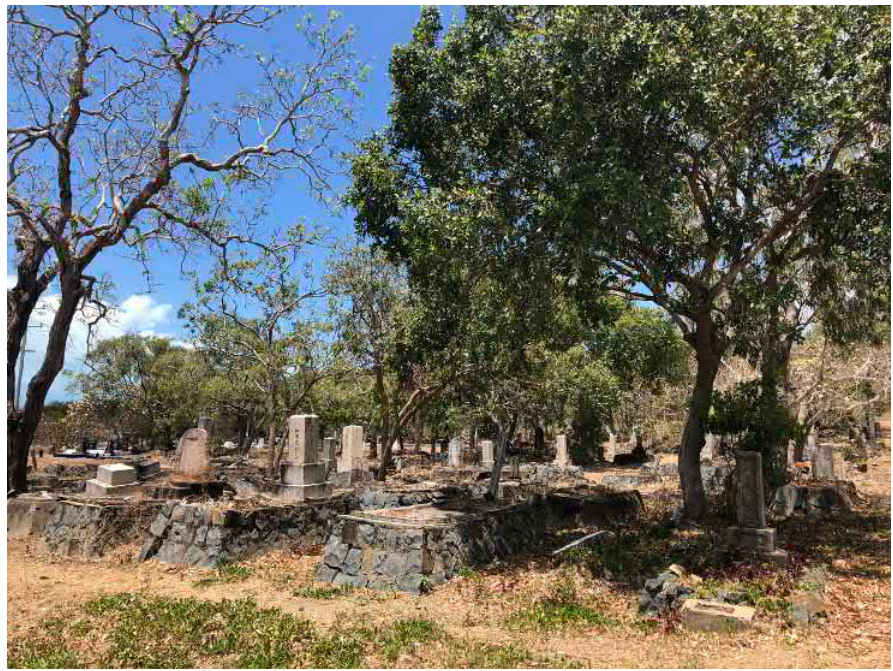
Figure 1: Thursday Island Cemetery. (Photo: Anna